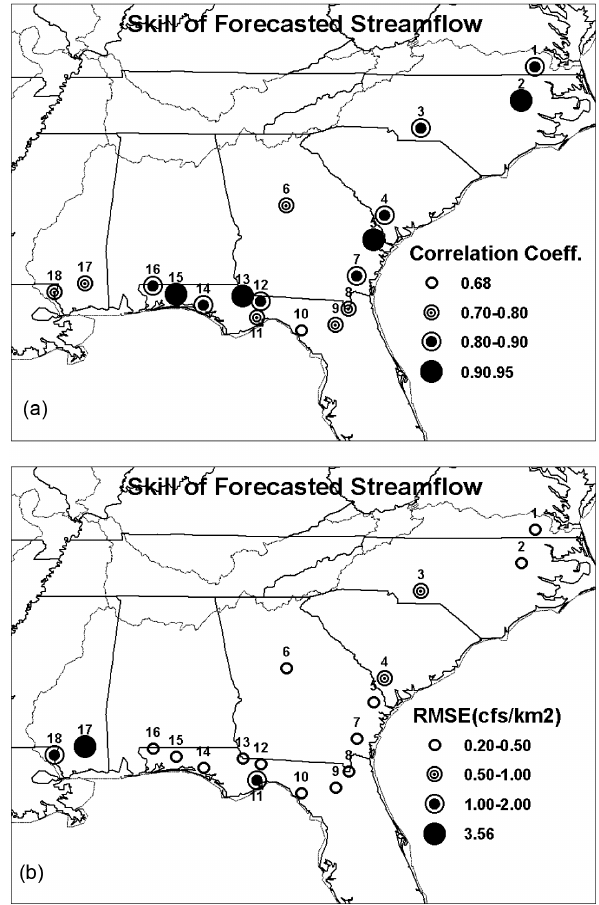
Figure 3. (a) Rank correlation and (b) RMSE (cfs per unit area) between observed daily streamflow and forecasted daily stream- flow for those days with TN loadings being available in the WQN